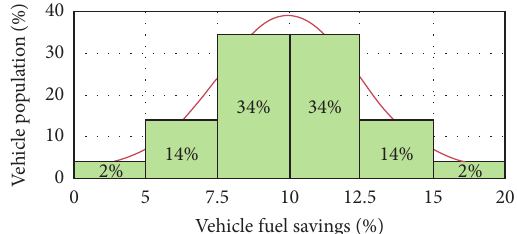
Figure 3: Vehicle fuel economy variability graph (speculative).